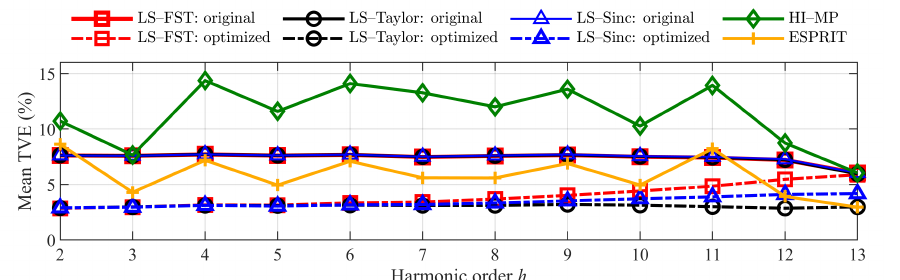
Figure 7. The mean TVE of LS-FST, LS-Taylor, and LS-Sinc with and without the proposed optimiza- tion, as well as the HI-MP and ESPRIT methods under noise interference test.